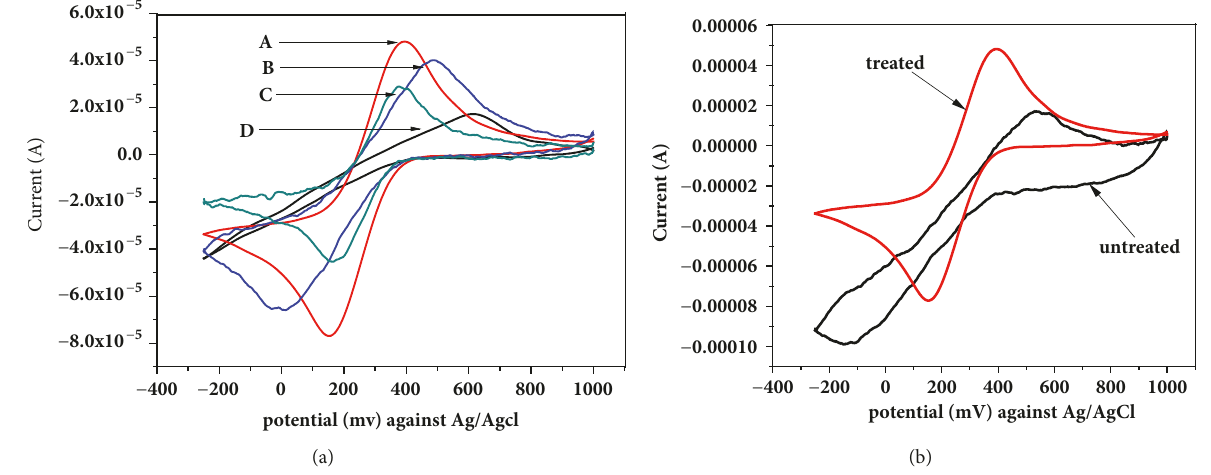
Figure 1: Cyclic voltammograms of 10 mM K 3 Fe (CN) 6 for (a) different exposure time in DMF (A) 5 min, (B) 30 min, (C) 2 min, and (D) 1 hr and comparison (b) of untreated and 5 min treated SPCE in DMF at a scan rate of 50mV/s.